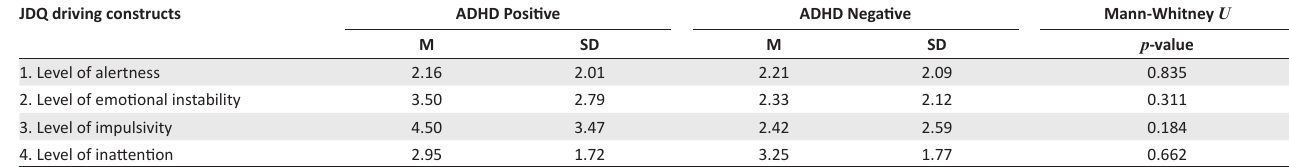
TABLE 4: Descriptive findings and tests of significance; Mann-Whitney U for the four driving constructs within the ADHD subgroups (ASRS V1.1). JDQ driving